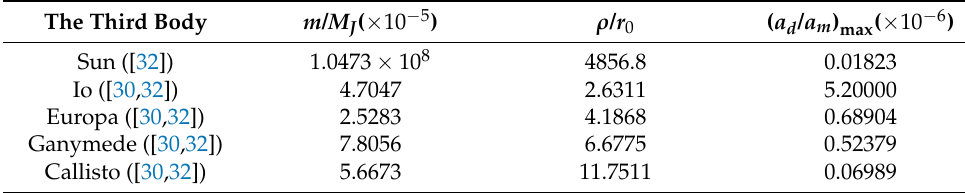
Table 2. The disturbing acceleration due to the third